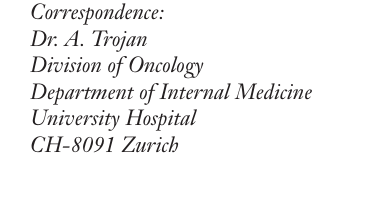
a. Sagittal T2- weighted scan: medullary infiltration of segments C6–Th1 ( ⇒ ), pathological fracture of the verte- bral body of C7 and Th1, secondary gibbus formation. Myelon compression by epidural compo- nent of the myeloma mass ( ∆ ). Extra- medullary tumor bulk ( ➚ ). b. Axial scan: infiltra- tion of Th1 vertebral body, circumferen- tially compressed myelon ( ➚ ), com- pressed of the left spinal nerve root ( ∆ ). Praevertebral ex- tramedullary tumor bulk ( ➘ ). c. Regression of the epidural and praever- tebral extramedullary tumor bulk, reexpan- sion of subarachnoid spaces ( (cid:4) ). d. Regression of Th1 vertebral infiltration ( (cid:4) ). Improved delin- eation of the spinal nerve roots ( (cid:5) ) and the wide spinal